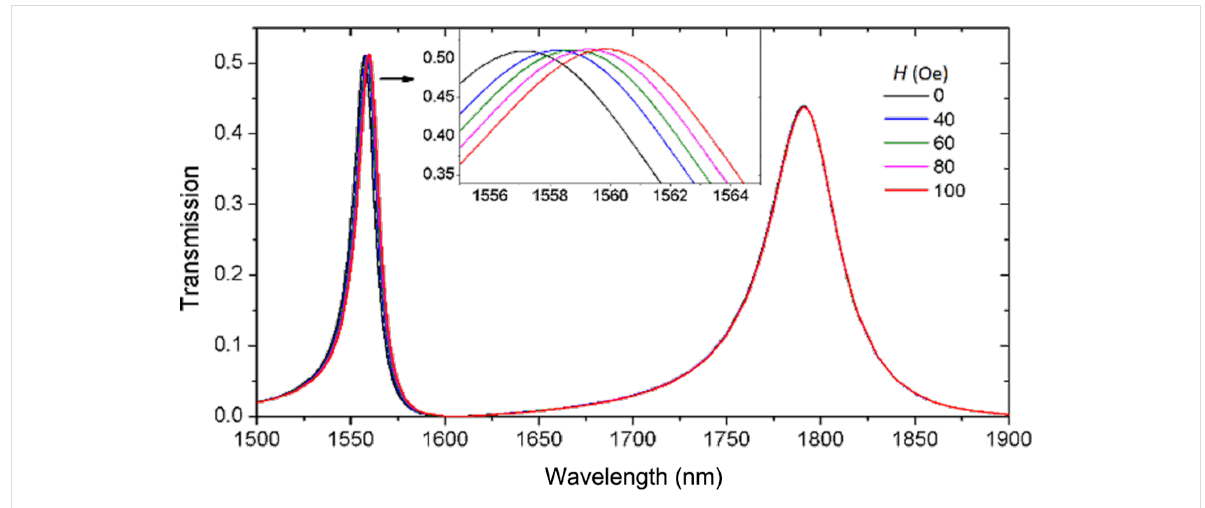
Figure 5: Transmission spectra as a function of the external magnetic field H . The parameters are same as in Figure 3 with the exception of the mag- netic field strength.